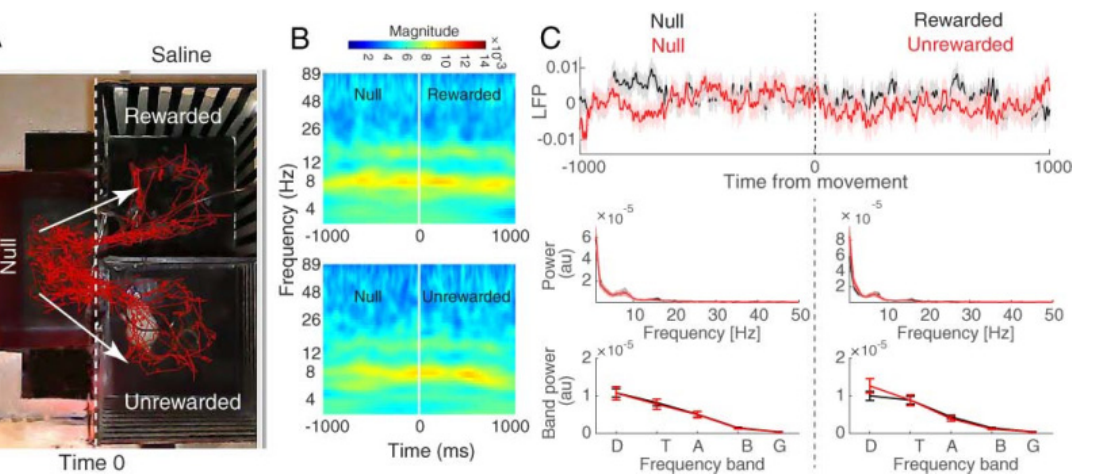
Figure 4. Hippocampal CA1 local field potential of morphine group. ( A ) Behavioral tracking of an ‐ imals during LFP recording in the post ‐ test session of CPP (red line), animals received morphine in the rewarded compartment while receiving saline in the unrewarded compartment. The dashed line indicates the time that the rat chooses to enter the rewarded or unrewarded side from null. The time window was defined as one millisecond before and after the entrance to each side (null–rewarded and null–unrewarded sessions). ( B ) Time–frequency representation based on CWT averaged across all recording trials and aligned to chamber entry. This figure shows the earliest modulation of theta frequency before time zero ( − 727 to − 153 ms). Power in theta band peaked before the entrance to unrewarded side (top). Time zero is defined as the time of entrance to each side from null (shown